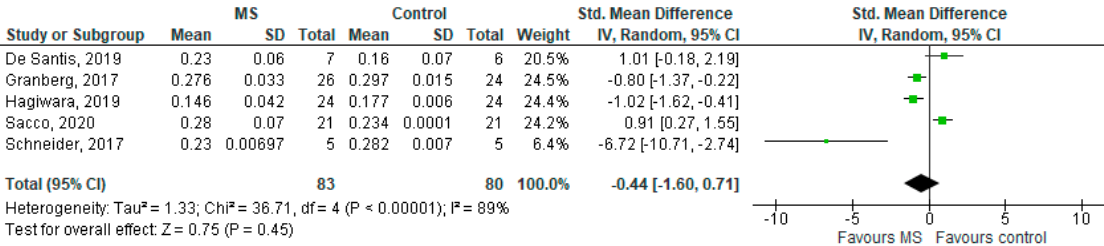
Figure 6. Forest plot for the standardised mean difference of the ODI in MS WM lesions (MS vs. control) [20,23–26].